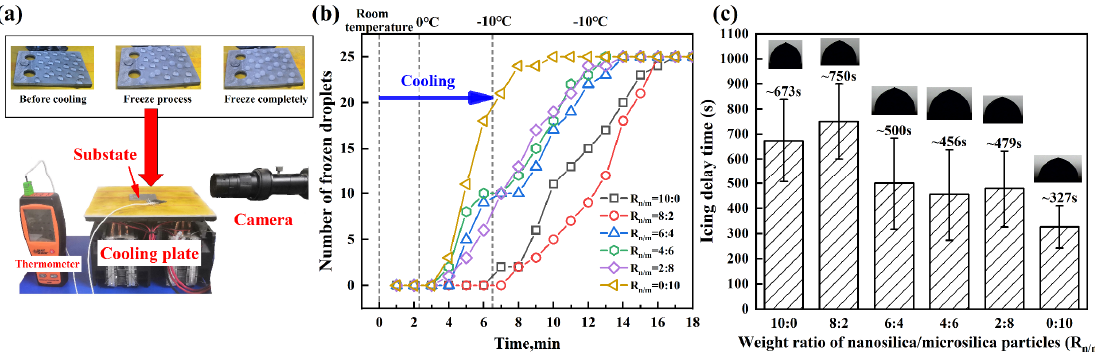
Figure 10. Freezing statistics experiment. ( a ) Scheme of freezing delay experimental set-up. ( b ) Statistics of freezing for 25 droplets deposited onto the coatings ( c ) Icing delay time of silica-filled coating with one standard deviation. The water drops were approximately 20 μL.